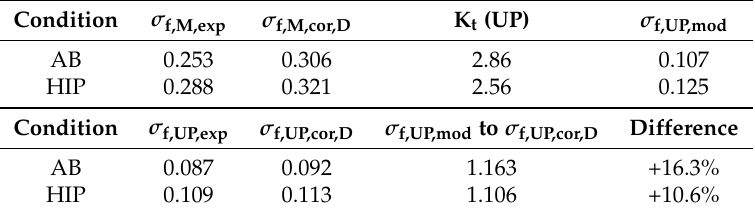
Table 10. Assessment of the surface roughness on the fatigue strength after Dietmann.